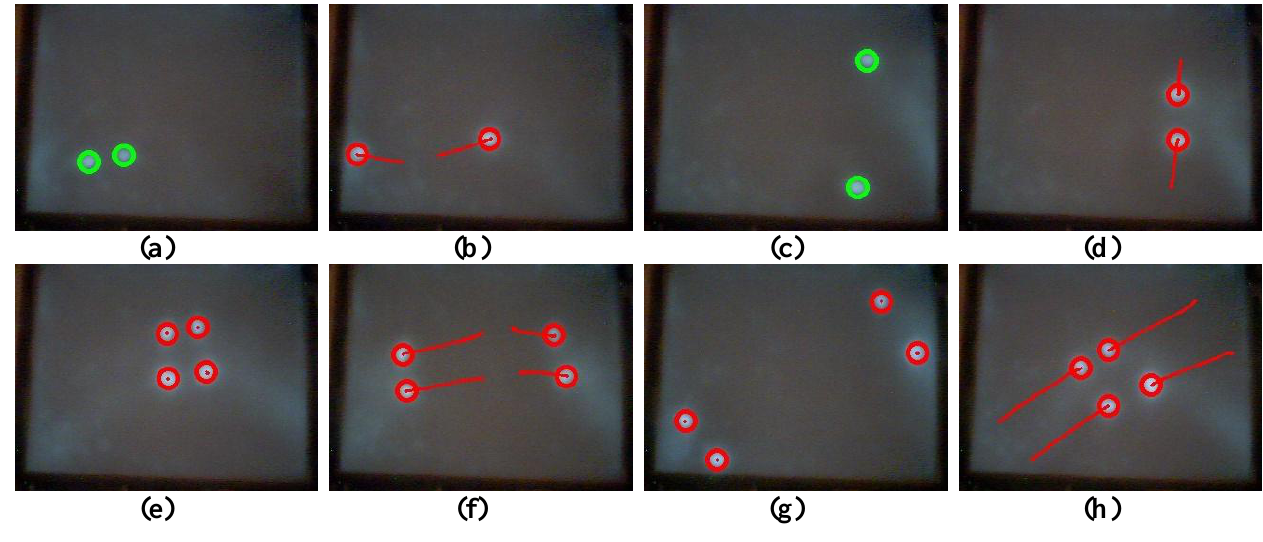
Figure 15. Touch finger detection and tracking results of the proposed system in Test sequence 5. (a) 427 th frame. (b) 475 th frame. (c) 3063 rd frame. (d) 3121 st frame. (e) 518 th frame. (f) 569 th frame. (g) 727 th frame. (h) 783 rd frame. (i) 785 th frame. (j) 858 th frame. (k) 221 st frame. (l) 307 th